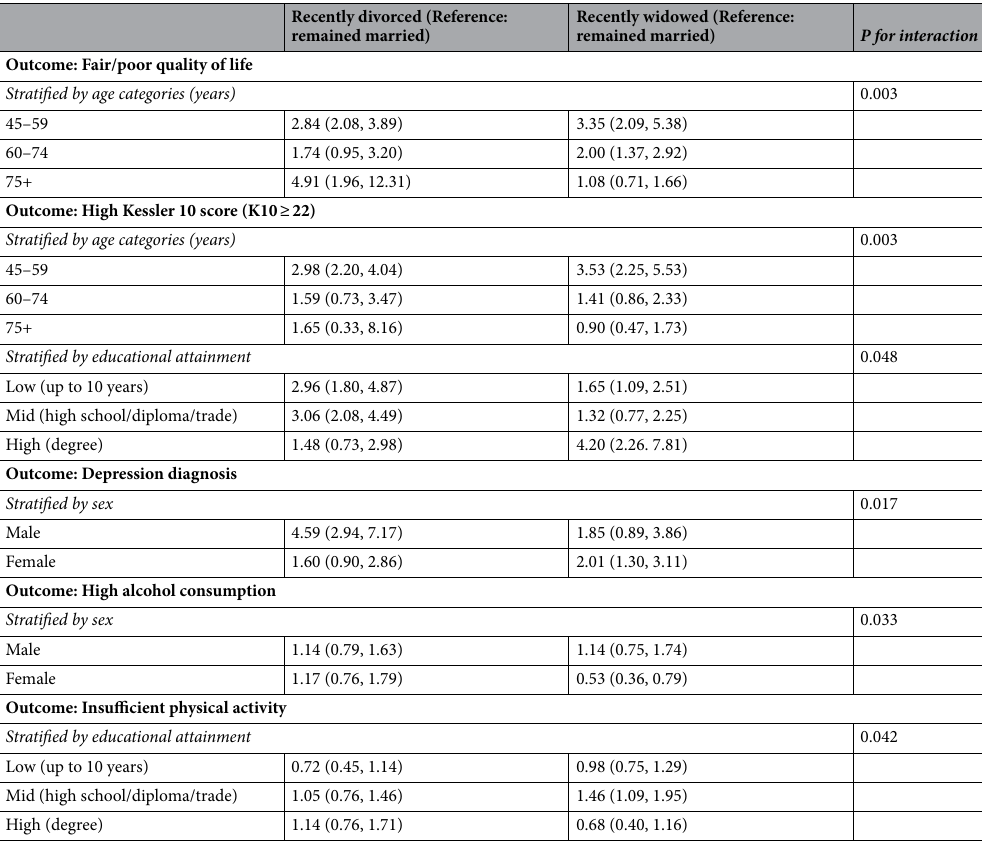
Table 4. Associations of marital disruption which occurred between T1 (2006–2009) and T2 (2010) with health-related outcomes at T2, stratified by statistically significant effect modifiers. T1: baseline data collection (2006–09), T2: first follow-up: 2010. Remained married: married at T1 and T2; Recently divorced: married at T1 and divorced/separated at T2; Recently widowed: married at T1 and widowed at